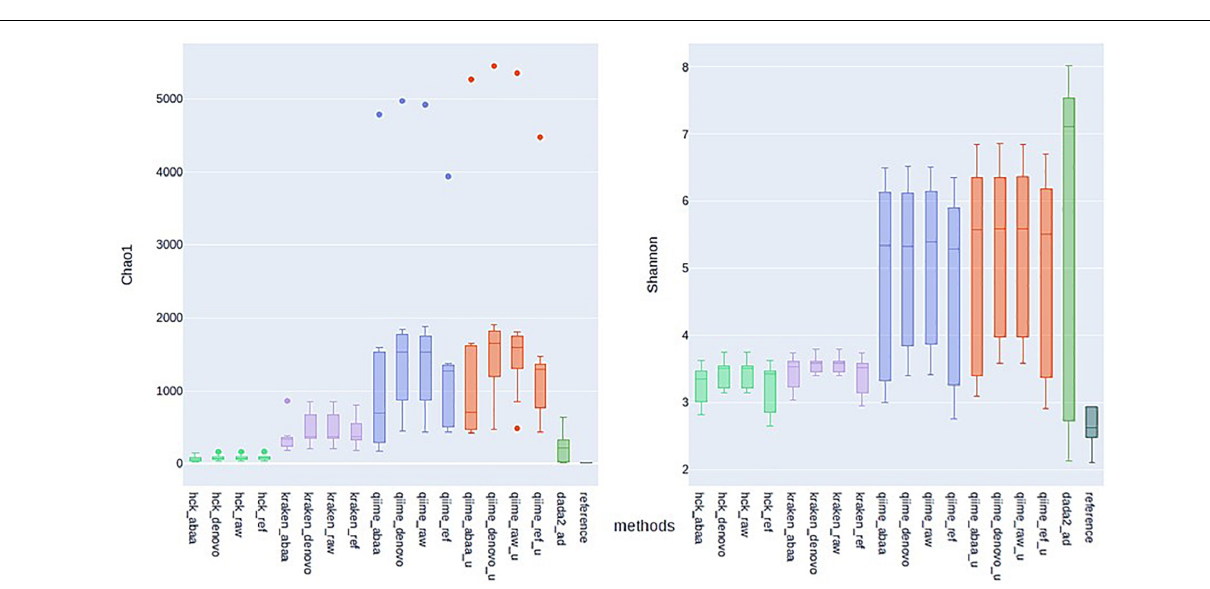
Frontiers in Microbiology |